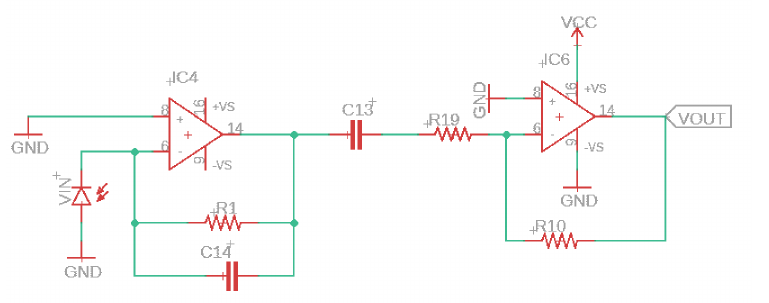
Figure 10. Current to voltage converter (first OPAMP) and photodiode amplifier (second OPAMP) circuit.